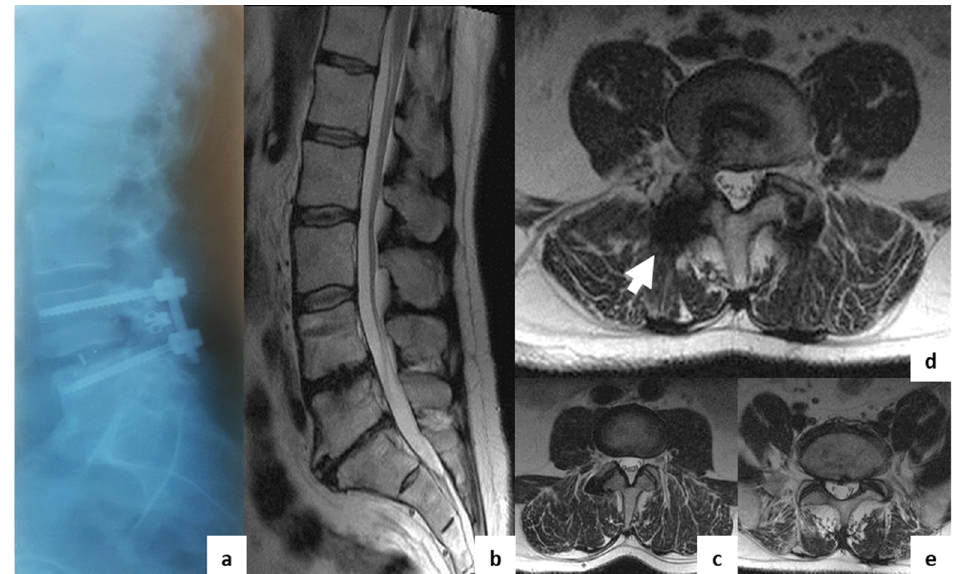
Figure 4. Postoperative T2w MRI of a 46-year-old female from group IIb with degenerative disc disease at L4–L5. ( a )—sagittal X-ray; ( b )—sagittal MRI; ( c )—axial MRI at L3–L4 (overlying segment); ( d )—axial MRI at L4–L5 (operation level); ( e )—axial MRI at L5–S1 (underlying segment). The white arrows indicate regions with visible artifacts.